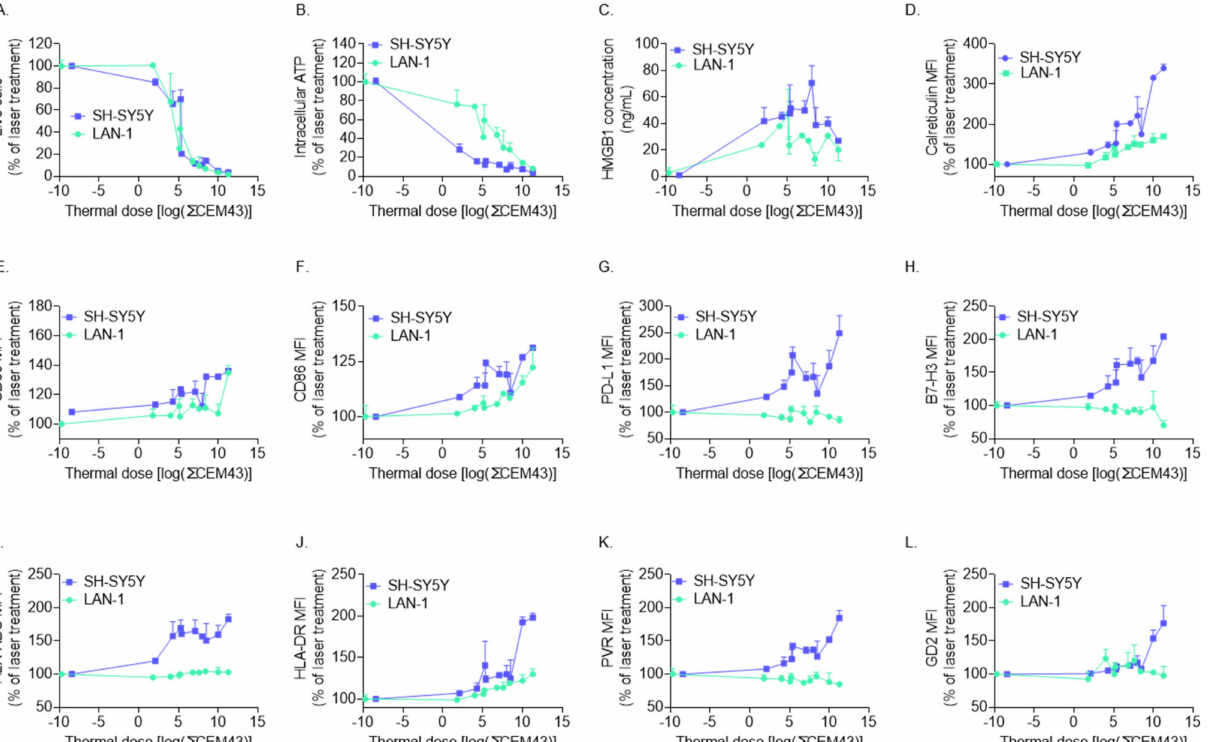
Figure 6. PBNP-PTT triggers greater immunophenotypic changes in MYCN-non-amplified SH-SY5Y cells than MYCN-amplified LAN-1 neuroblastoma cell line in vitro. SH-SY5Y (blue) and LAN-1 (green) cells were treated with varied thermal doses via PBNP-PTT and analyzed for ( A ) % live cells ( B ) intracellular ATP, ( C ) secreted HMGB1, and cell surface expression levels of ( D ) calreticulin, ( E ) CD80, ( F ) CD86, ( G ) PD-L1, ( H ) B7-H3, ( I ) HLA-ABC, ( J ) HLA-DR, ( K ) PVR, and ( L ) GD2. Data represent mean ± SD ( n = 2 independent